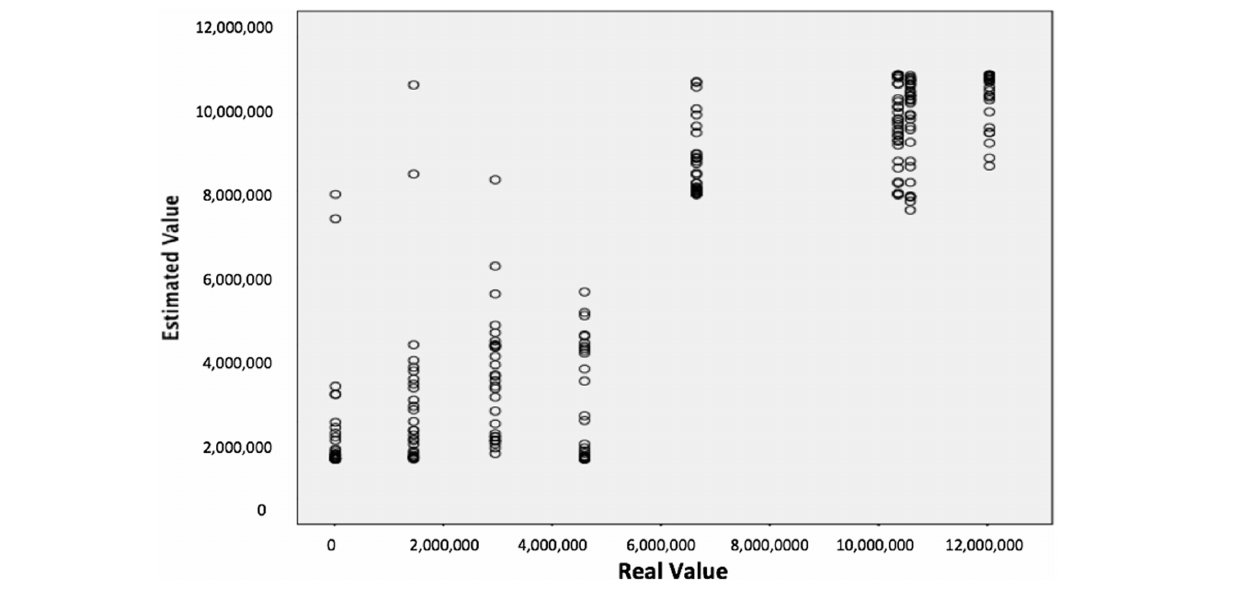
FIGURE 4 | Scatterplot showing predicted vs. observed-values for number of